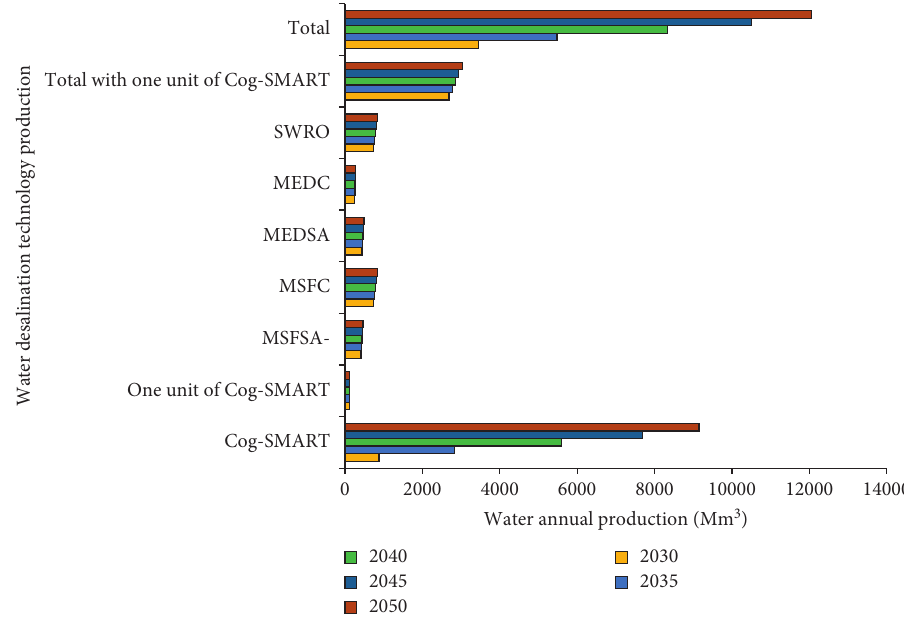
Figure 14: Annual water desalinated (Mm 3 ) by Cog-SMART-100 against other technologies.